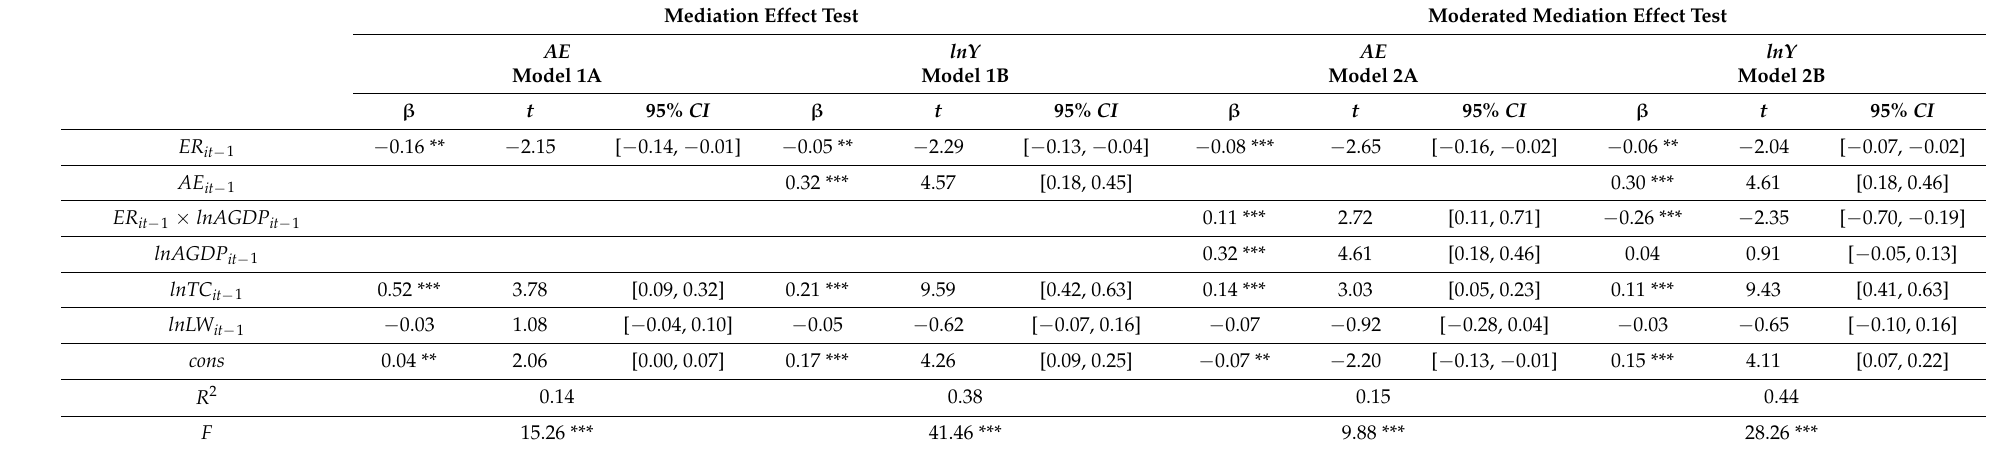
Table 2. Regression results of the moderated mediation model (Bootstrap = 5000)